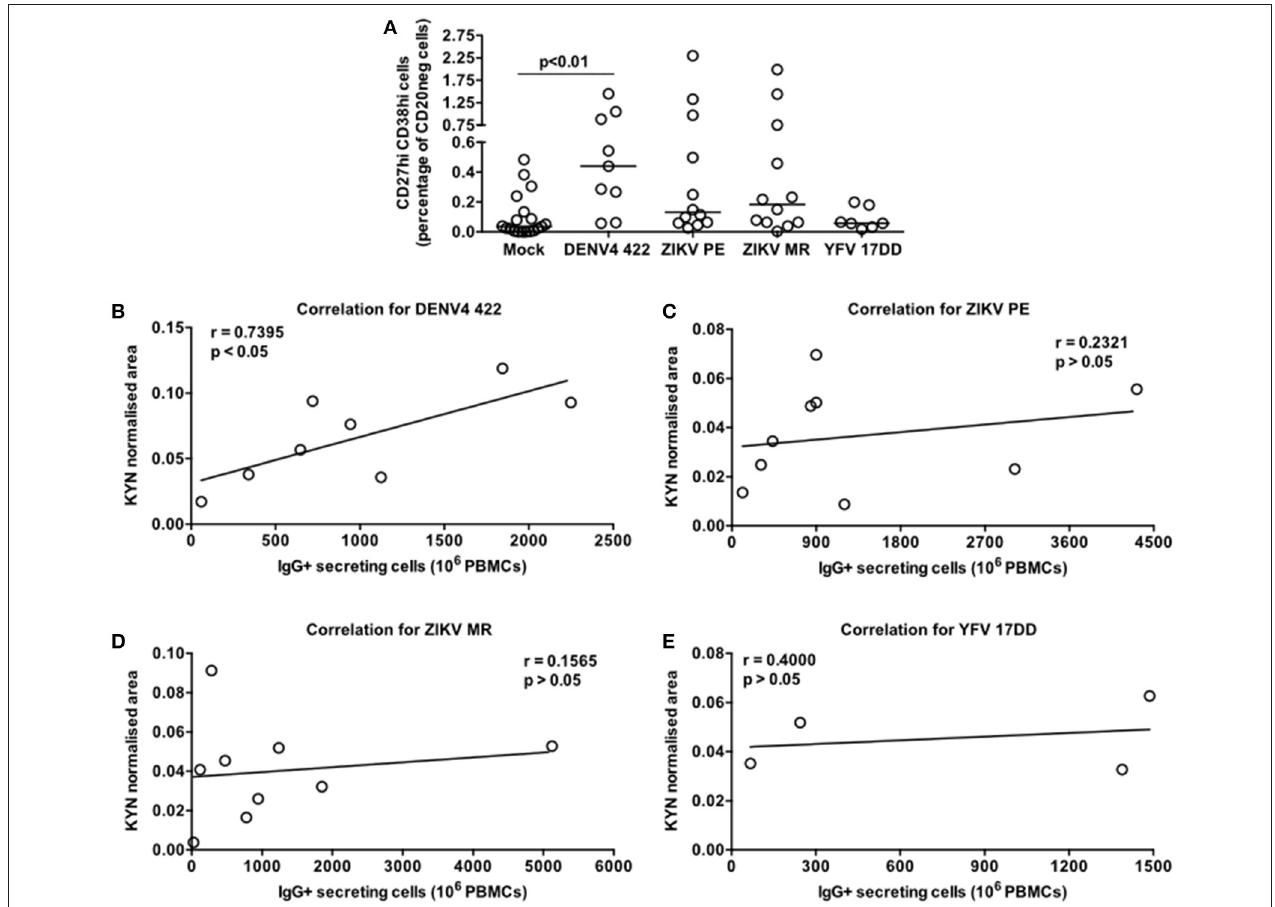
FIGURE 6 | Contrasting pattern of the tryptophan metabolism induced in PBMC cultures stimulated by a DENV4 clinical isolate (422) or flaviviruses that elicit low ASC responses in vivo (ZIKV MR766, ZIKV PE243, and attenuated Yellow Fever 17DD). Different PBMC cultures derived from healthy donors had cells and supernatants obtained at day 7 of the cultures. (A) ASC percentage quantified through FACS for different flavivirus-stimulated PBMC cultures. (B–E) Correlation between the Kyn levels and ASC numbers (counted through ELISPOT) derived from each cell